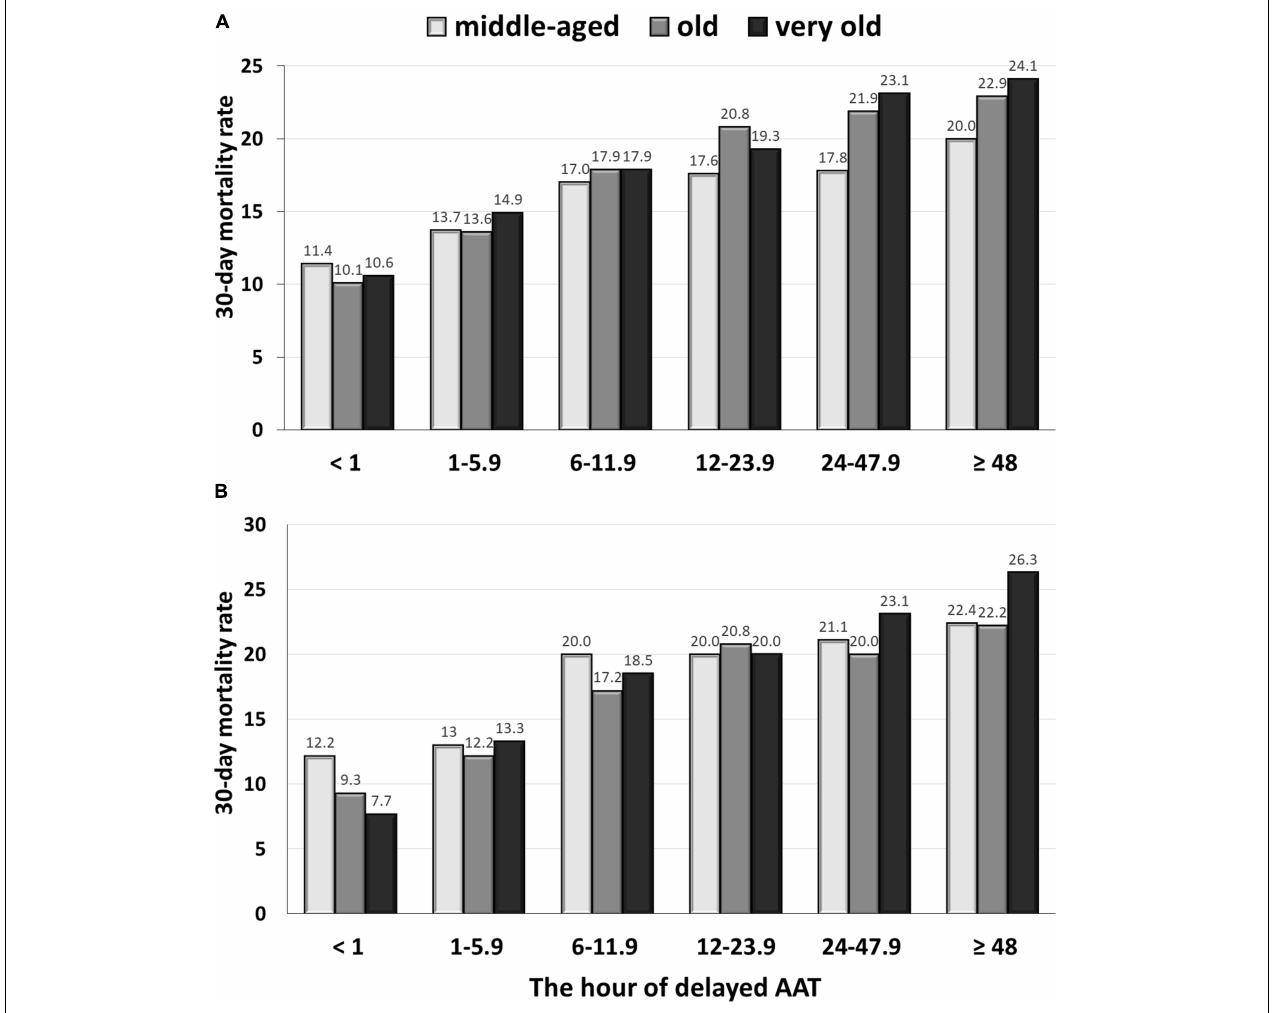
FIGURE 1 | The delayed AAT-related trend in 30-day crude mortality rates among the middle-aged, old, and very old groups: the overall (A) and propensity score-matched (B) patients. AAT, appropriate antimicrobial therapy.